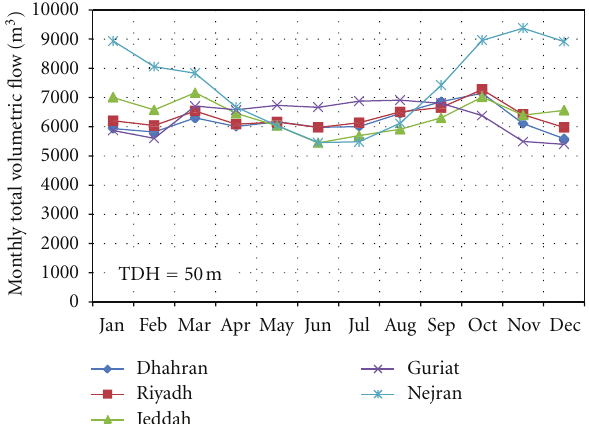
Figure 4: Monthly total volumetric flow of water from a well with total dynamic head of 50 m using solar PV-operated Goulds model 45J series pump for five di ff erent sites in Saudi Arabia.